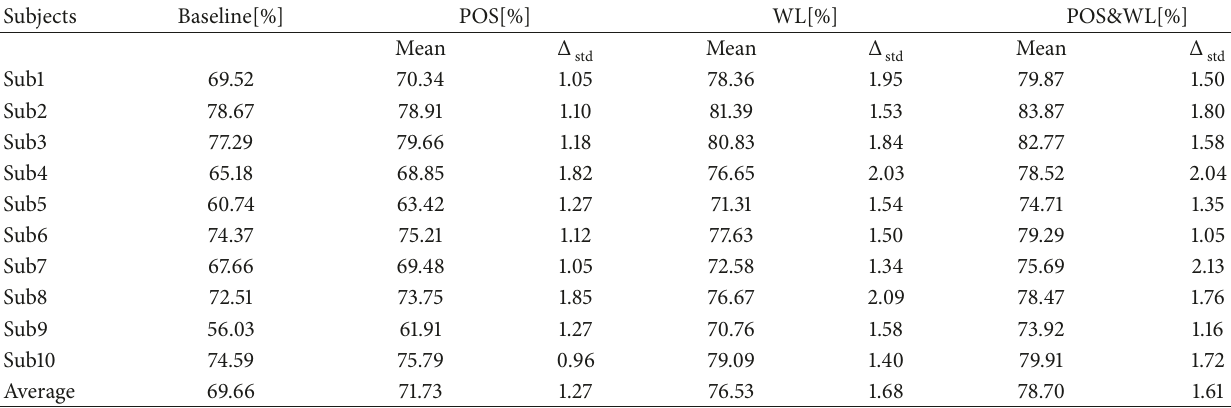
Table 3: Mean accuracy and standard deviation (averaged over 100 runs) for the fixation prediction